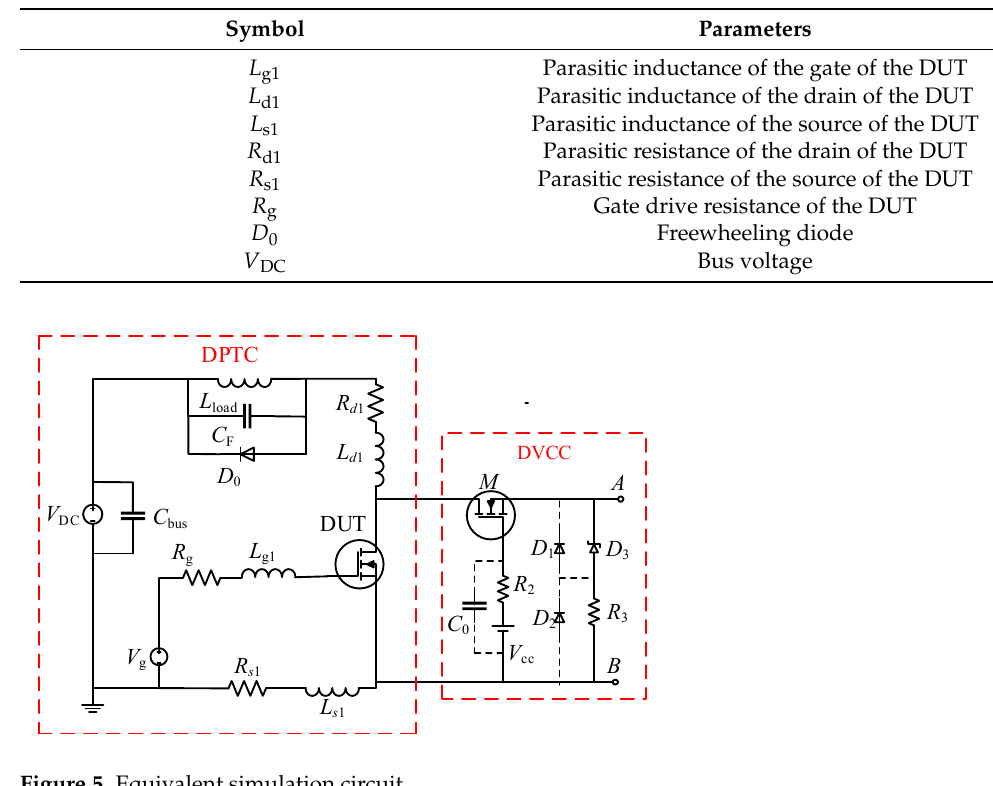
Table 2. Circuit parameter index.